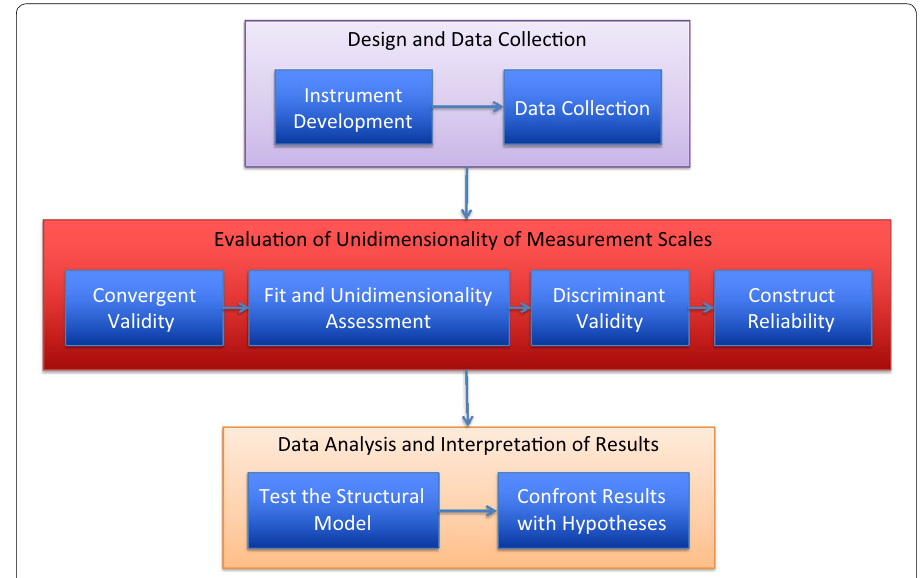
Fig. 7 Procedures for research using structural equation modelling and confirmatory factor analysis (Source: Adapted from Koufteros [94], Kline [93] and Bollen [91])